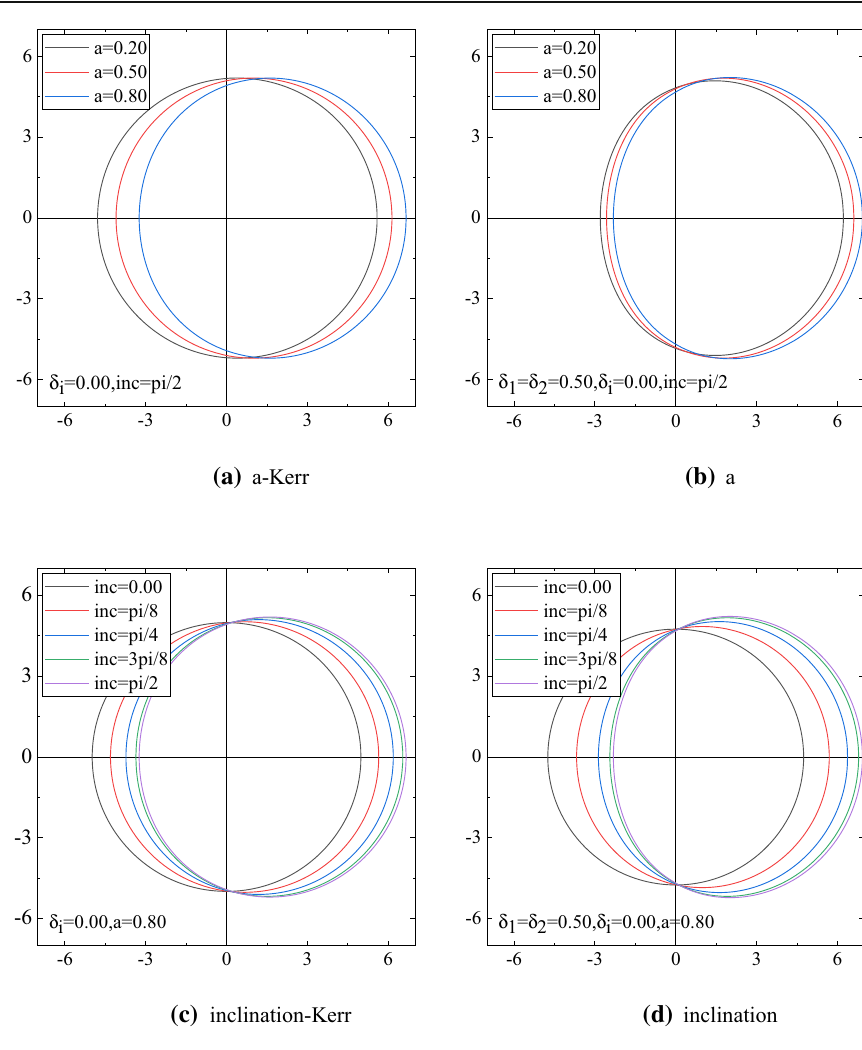
Fig. 5 Ray-traced shadow images in the Kerr and KRZ spacetime. The a is for the shadow with different spin a in the Kerr spacetime, the b is for the shadow with different spin a in the KRZ spacetime, the c is for the shadow with different inclination in the Kerr spacetime, the d is for the shadow with different inclination in the KRZ